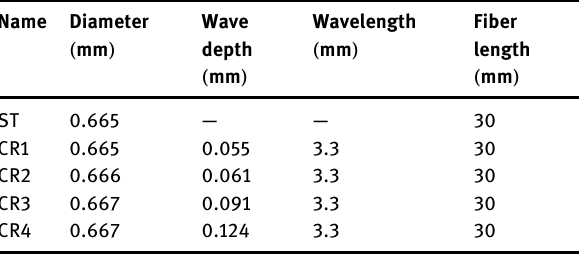
Table 1: Dimensions of straight and crimped fi bers